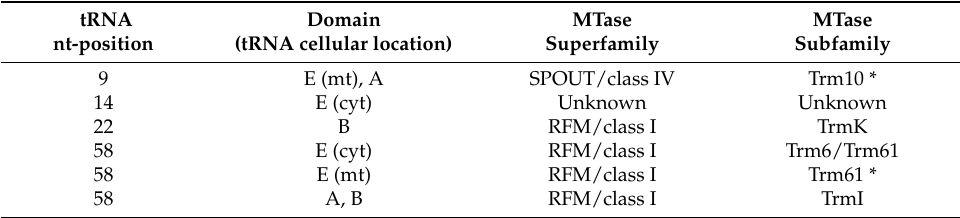
Figure 3. Topology diagrams of the classical folds for ( A ) the SPOUT superfamily (two subtypes), and ( B ) the Rossmann-fold methyltransferase (RFM) superfamily. SAM: S -adenosyl- L -methionine. Table 1. Overview of the SPOUT and RFM methyltransferases (MTases) responsible for m 1 A modifications at nucleotide positions 9, 14, 22, and 58, with the domain(s) of origin for each enzyme class and the cellular localisation of the substrate tRNA.